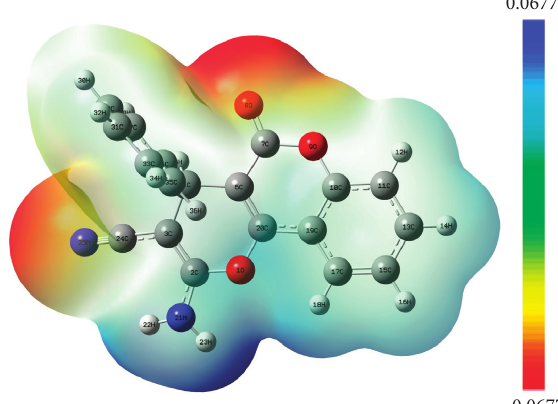
Figure 7: The MEP surface graph of Chrom-D.